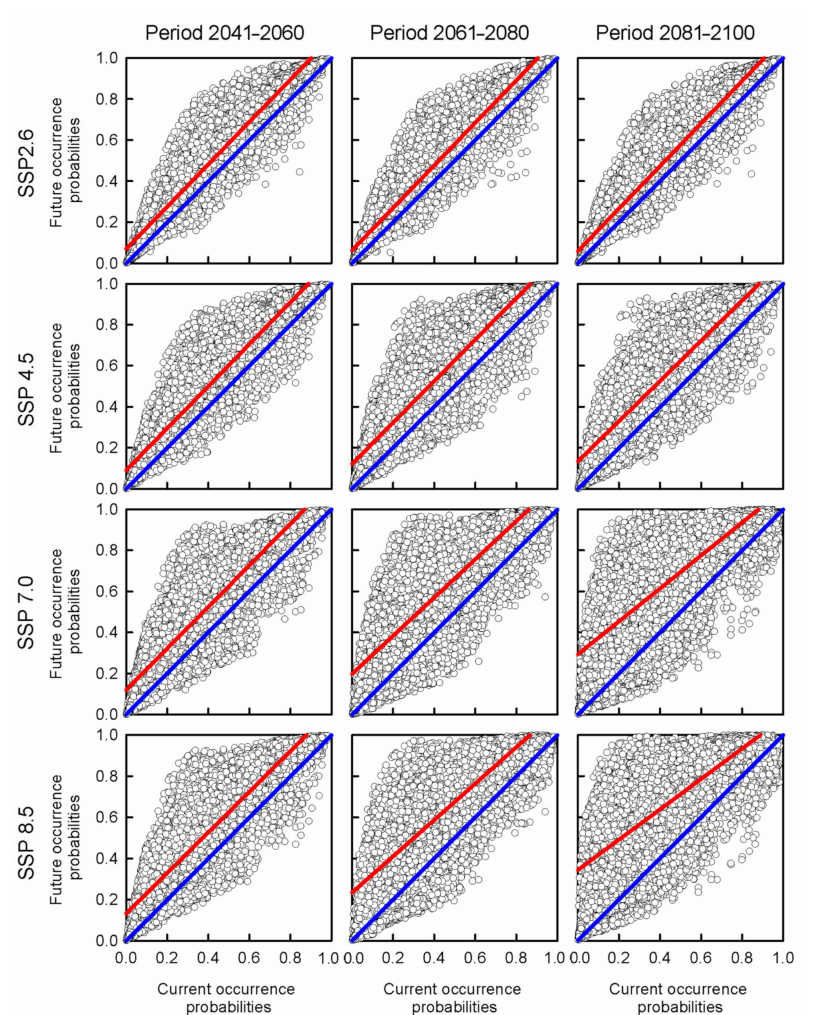
Figure 4. Graphs of the linear regressions analysis between current climate and climate change scenarios for the periods of 2041–2060, 2061–2080, and 2081–2100 for all the shared socioeconomic pathways. The color blue indicates the theoretical curve, and the color red shows the linear regression functions for each